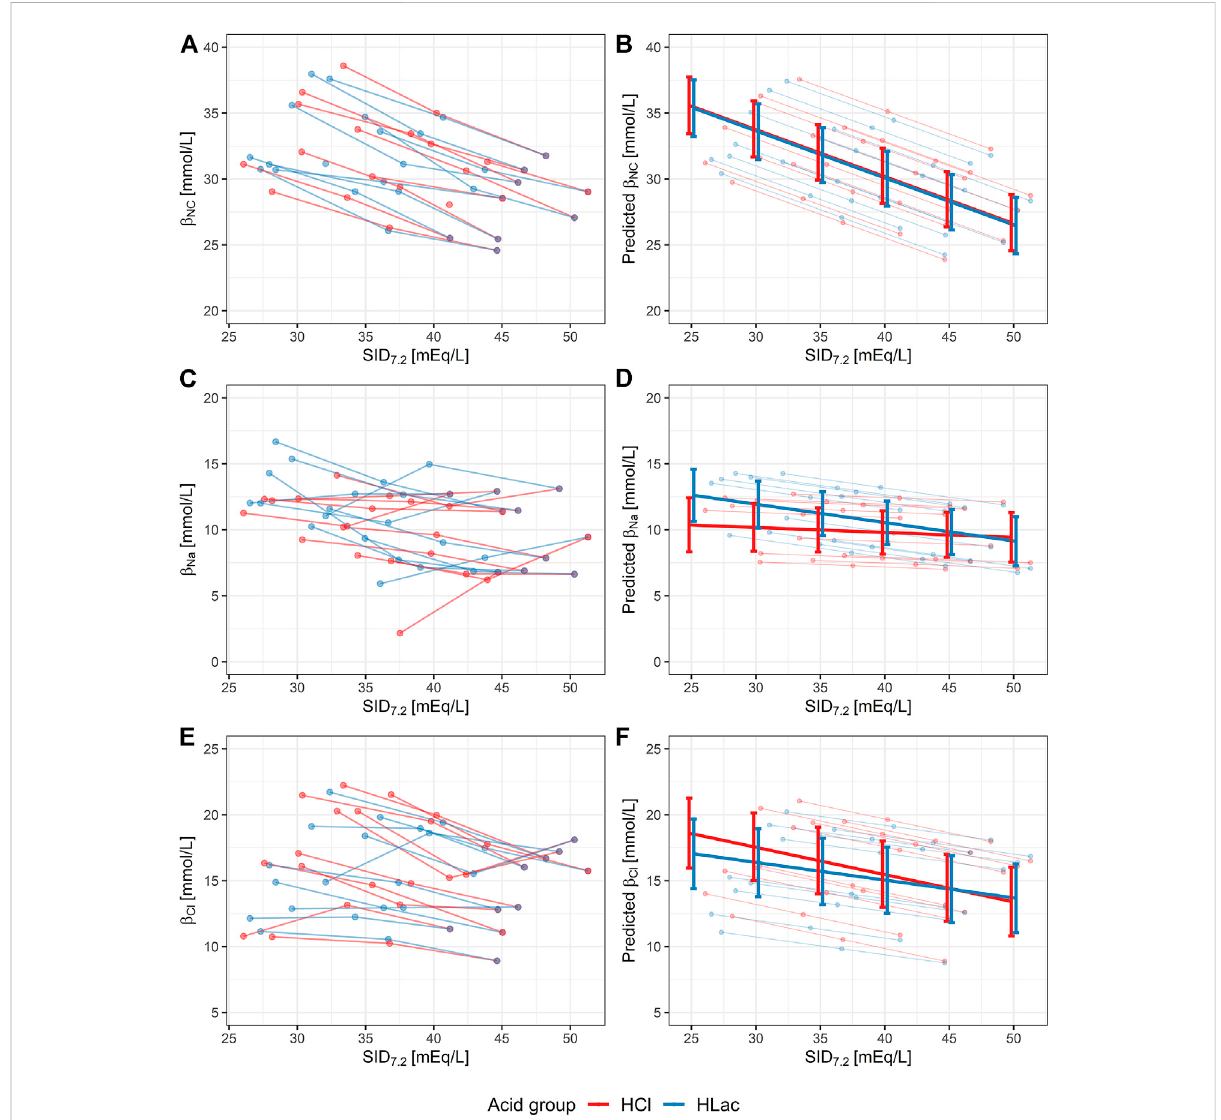
FIGURE 2 Noncarbonic buffer power ( β NC ) and non-carbonic buffer power due to change of [Na + ] and [Cl − ] (i.e., β Na and β Cl ) in aliquots with varying degrees of hyperchloremic (red) or lactic (blue) metabolic acidosis, characterized quantitatively by a reduction in SID 7.2 . The lines connect the aliquots treated with one type of acid and the control aliquot of each volunteer. Aliquots that were excluded due to bad fi t of the interpolated curve are not shown. (A,C and E) Original data. (B,D and F) Results of linear mixed-effect model with random intercept (individual ID) showing 95% con fi dence intervals. SID 7.2 , acid type, and their interaction were considered fi xed effects. In the case of β NC , the model was simpli fi ed by removing the fi xed effect of interaction between the acid type and SID 7.2